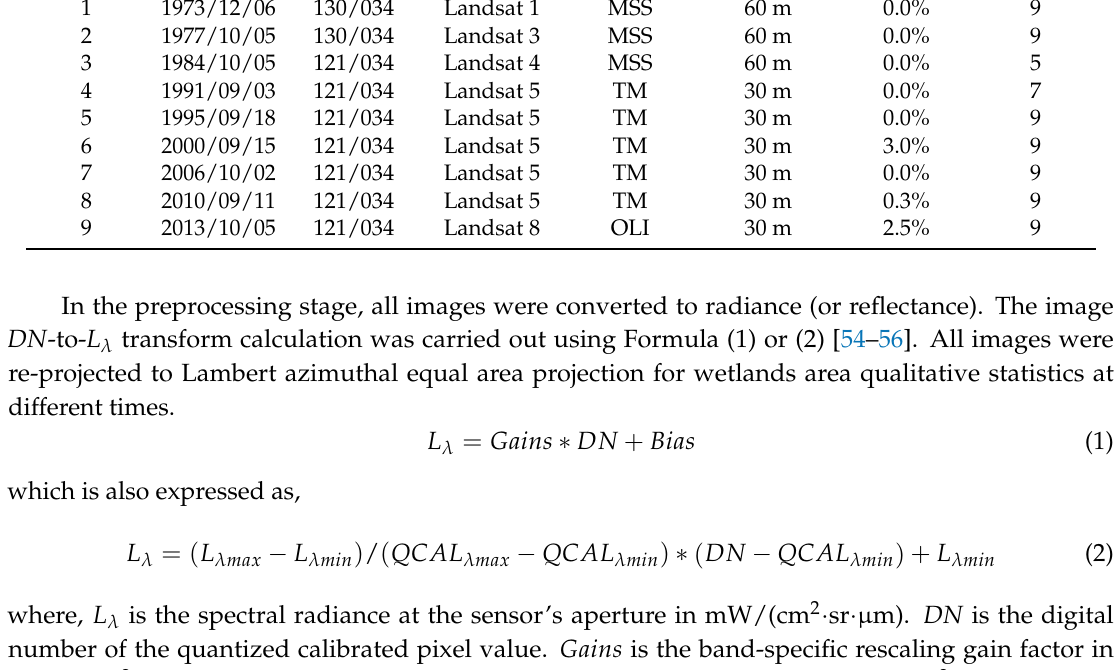
Table 1. List of remotely sensed images of the Yellow River Delta wetlands used for mapping.